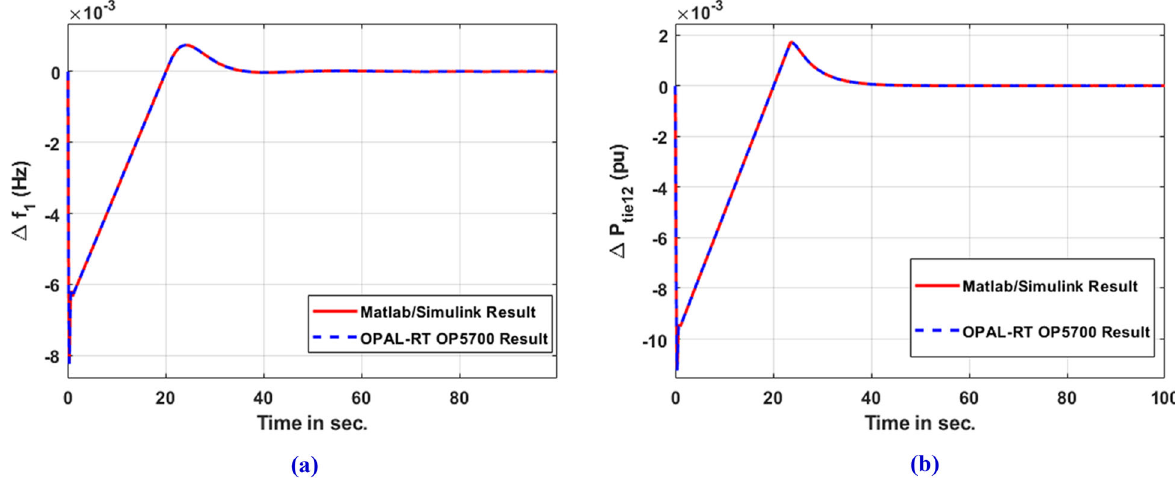
Fig. 12 OPAL-RT OP5700 RCP/HIL FPGA real-time simulator vs MATLAB/SIMULINK results